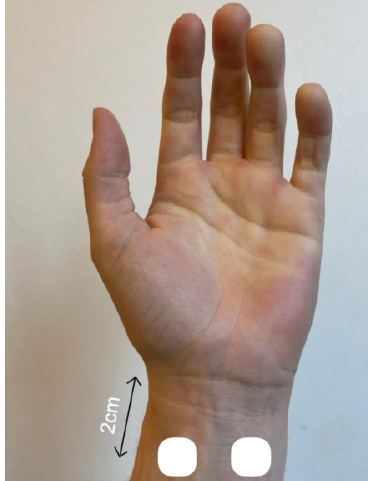
Figure 4: Electrode placement for the reference test